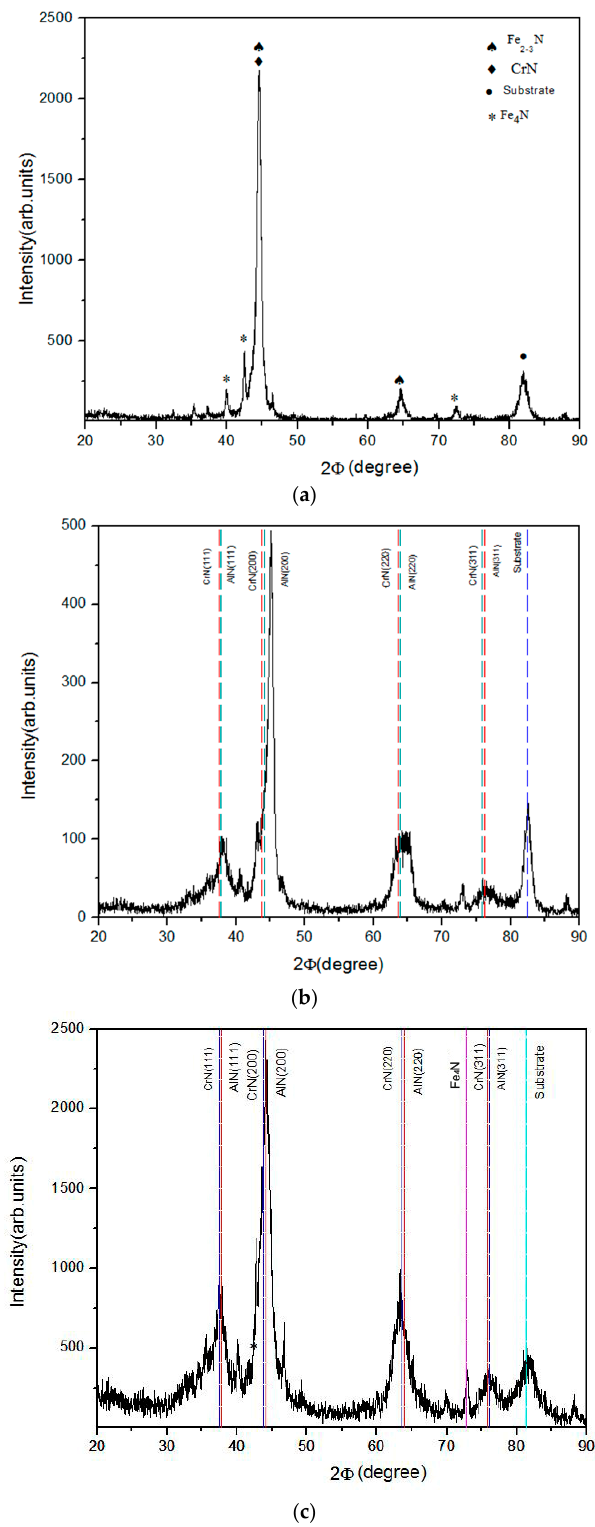
Figure 2. XRD pattern of ( a ) plasma nitriding (PN), ( b ) AlCrSiN, and ( c ) PN + AlCrSiN samples.